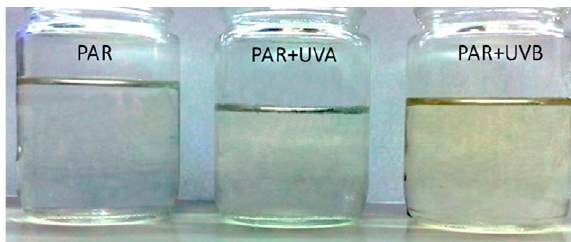
Fig. 7. – Appearance of seawater in which Sargassum filipendula was cultivated after 10 days of experimentation at three different radiation